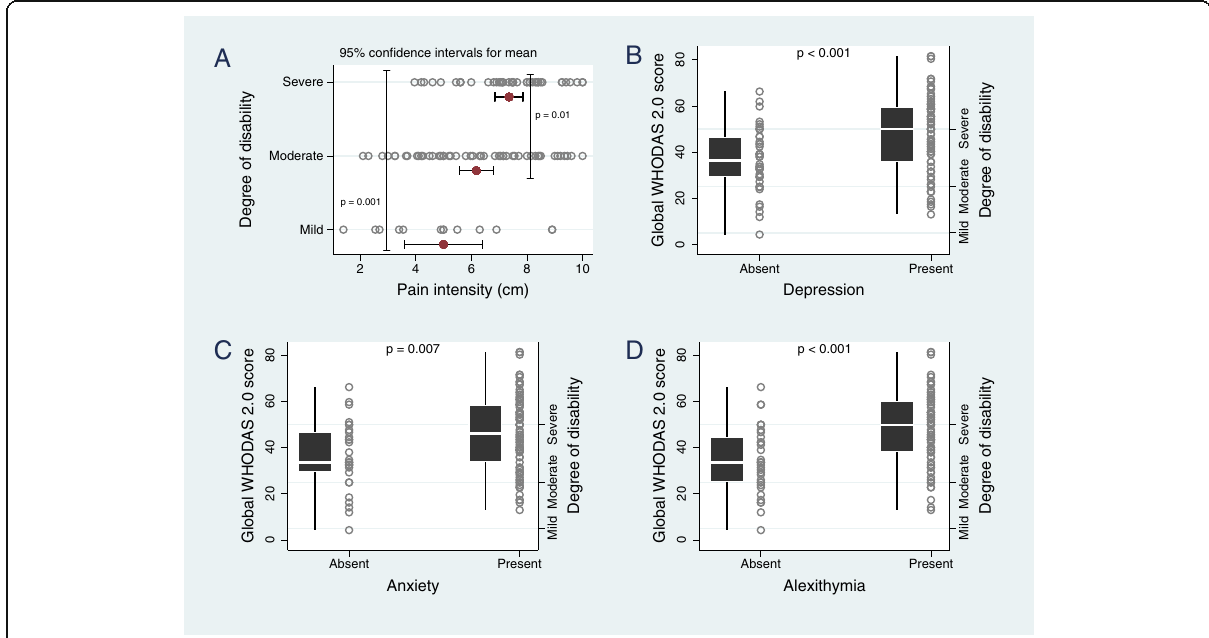
Fig. 1 Graph of 95% confidence intervals of mean pain intensity by disability degree ( a ). Box plot of WHODAS 2.0 global score by depression ( b ) anxiety ( c ) and alexithymia ( d ). Upper and lower whiskers represent 1.5 times and − 1.5 times interquartile range; upper and lower hinges represent 25 and 75% quartiles; middle represents median or 50% quartile. Each dot represents a